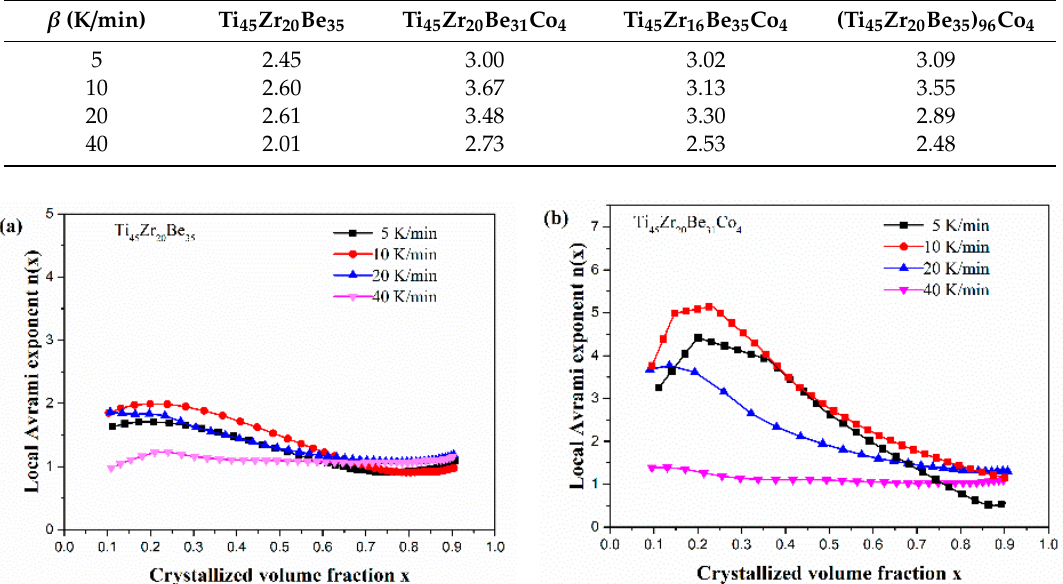
Figure 13. Figure 13. JMA plots for ( a ) Ti 45 Zr 20 Be 35 , ( b ) Ti 45 Zr 20 Be 31 Co 4 , ( c ) Ti 45 Zr 16 Be 35 Co 4 , and ( d ) Table 7. The values of n derived from Figure 13. Table 7. The values of n derived from Figure 13.